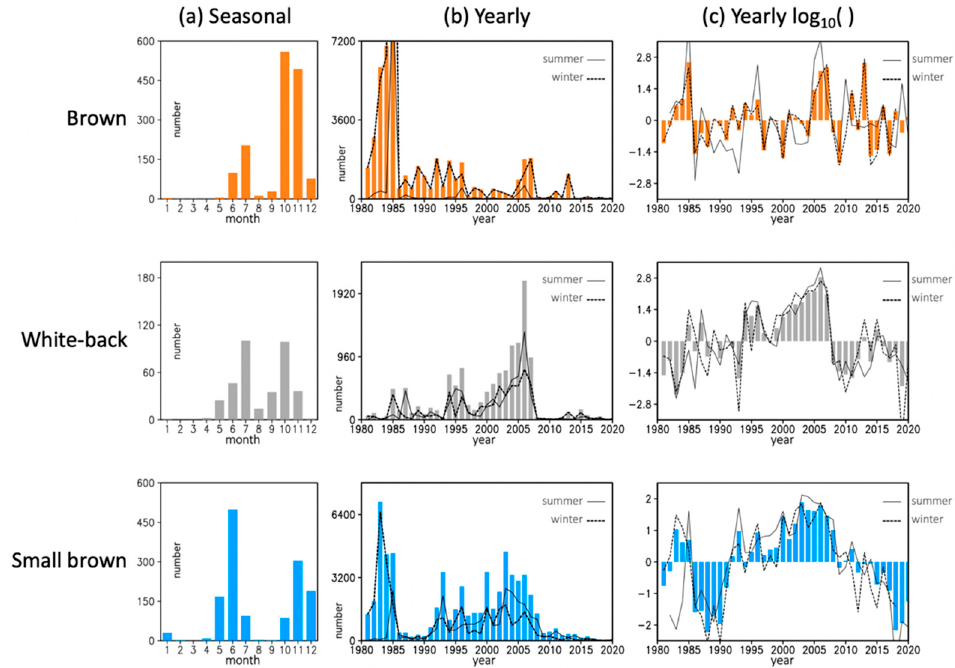
Figure 2. Numbers of pest counts for ( a ) long-term seasonal distribution, ( b ) yearly accumulations, and ( c ) same as ( b ) after the logarithmic transformation Log10 for (top to bottom) brown, white-back, and small brown rice planthoppers from the trap nets.